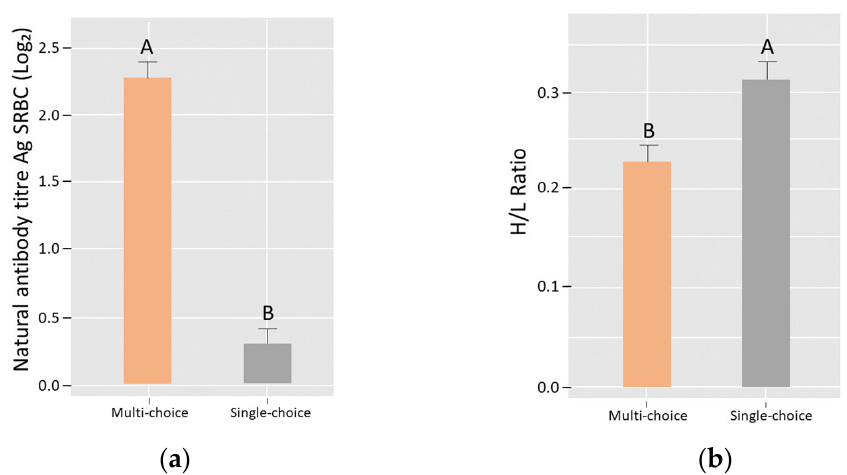
Figure 3. Immunological effects of “multi ‐ choice” and “single ‐ choice” treatments for ( a ) natural antibody titer against sheep red blood cells (SRBC), presented as the Log 2 of the highest dilution yielding significant agglutination (mean and SE; “multi ‐ choice”: 39; “single ‐ choice”: 40 chicks were analyzed) and ( b ) H/L ratio (estimated marginal mean and SEM; “multi ‐ choice”: 36; “single ‐ choice”: 39 chicks were analyzed) in blood sampled from 16 ‐ day ‐ old domestic fowl layer chicks. Different letters (A,B) indicate significant treatment differences.